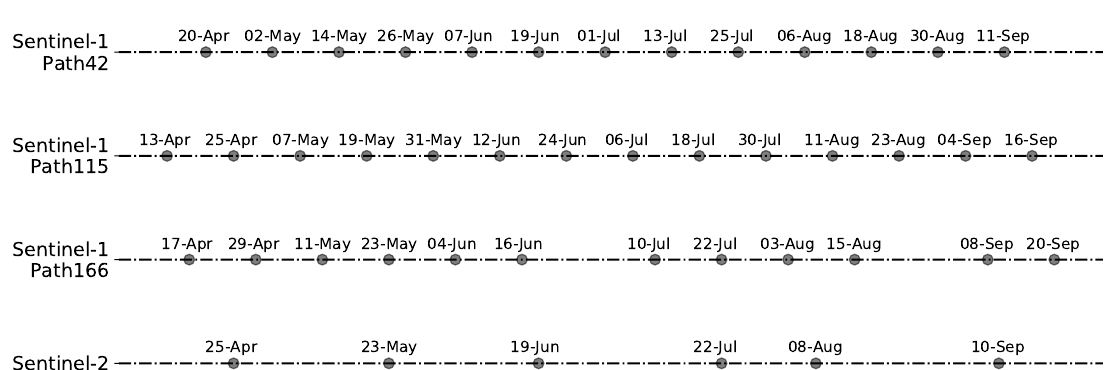
Figure 5. Photograph of the field survey conducted in the Eastern Washington, in March 2012. The geospatial characteristics of wetlands were investigated.